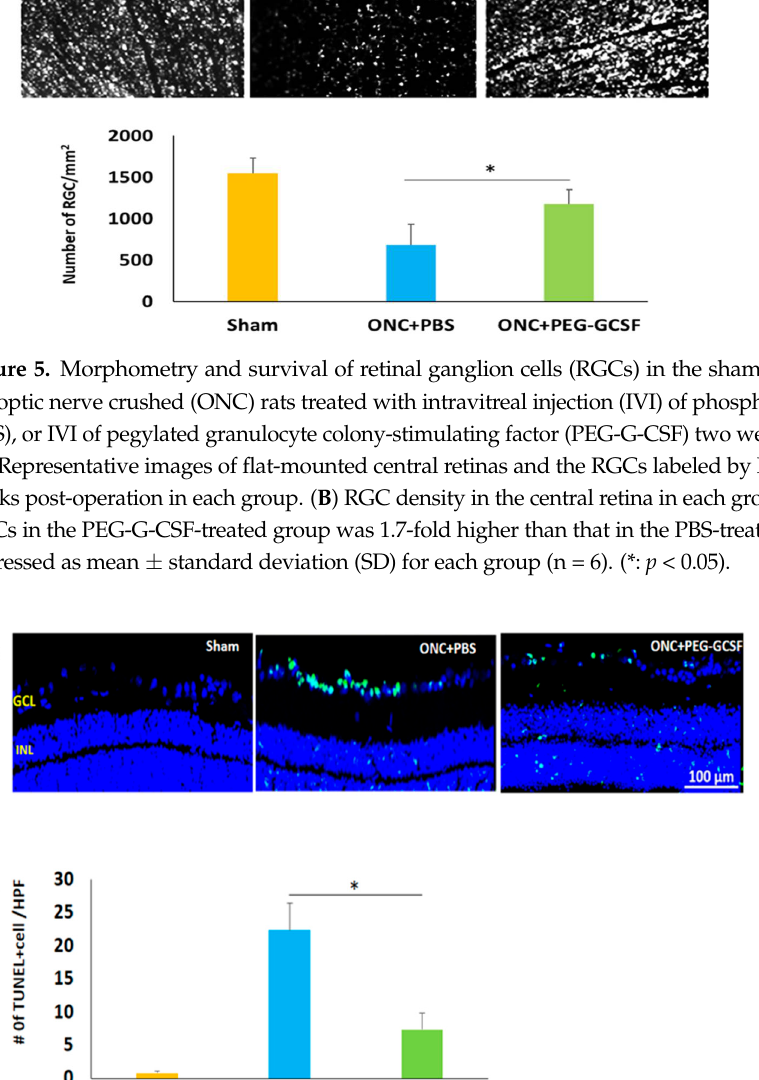
Figure 6. Measurement of retinal ganglion cell (RGC) apoptosis in the RGC layer by in situ Terminal deoxynucleotidyl transferase dUTP nick end labeling (TUNEL) assay at two weeks post-sham-operated and post-optic nerve crushed (ONC) with intravitreal injection (IVI) of phosphate-buffered saline (PBS), or IVI of pegylated granulocyte colony-stimulating factor (PEG-G-CSF). ( A ) Representative images of double-stained apoptotic cells in the retina in each group. The apoptotic cells were stained in green, and the cell nuclei were counterstained with DAPI staining in blue. ( B ) Quantification of apoptotic cells in RGC layer per high-power field (HPF). Treatment with PEG-G-CSF significantly reduced the number of apoptotic RGCs by 3.1-fold when compared with the PBS-treated group. Data are expressed as mean ± standard deviation (SD) for each group (n = 6). (*: p < 0.05).